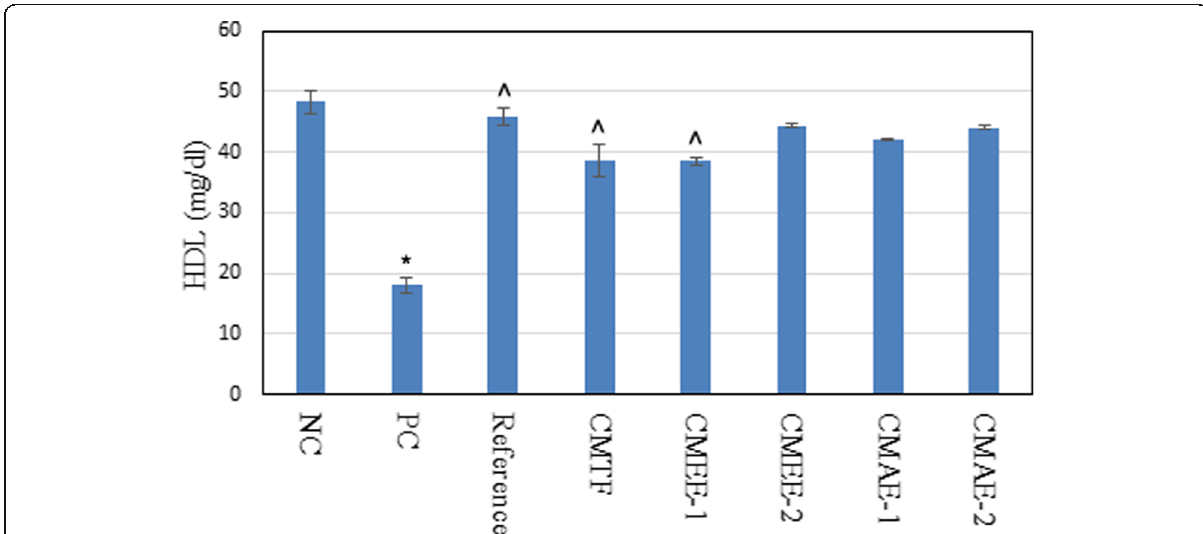
Fig. 5 Effect of C. melo fraction and extracts on the HDL level of animals. Values are expressed as mean ± standard error of mean ( n = 6), significantly different at * P < 0.05, vs the normal control group; △ P < 0.05, vs the diabetic control group analyzed by one-way ANOVA followed by Tukey ’ s multiple comparison test. CMTF, Cucumis melo toluene fraction (ethanolic extract); CMEE 1, Cucumis melo ethanolic extract (400 mg/kg); CMEE 2, Cucumis melo ethanolic extract (200 mg/kg); CMAE, Cucumis melo aqueous extract (400 mg/kg); CMAE, Cucumis melo